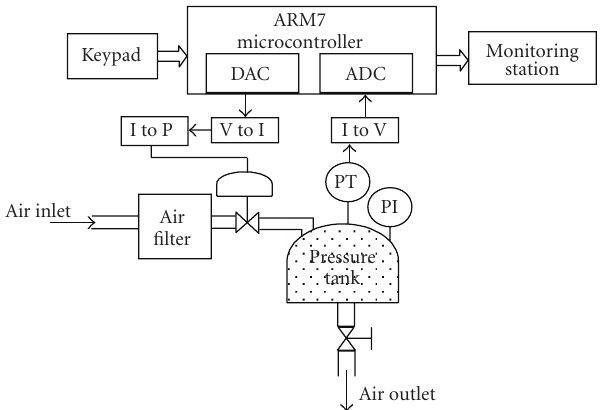
Figure 4: Schematic diagram of the pilot pressure regulating sys- tem.